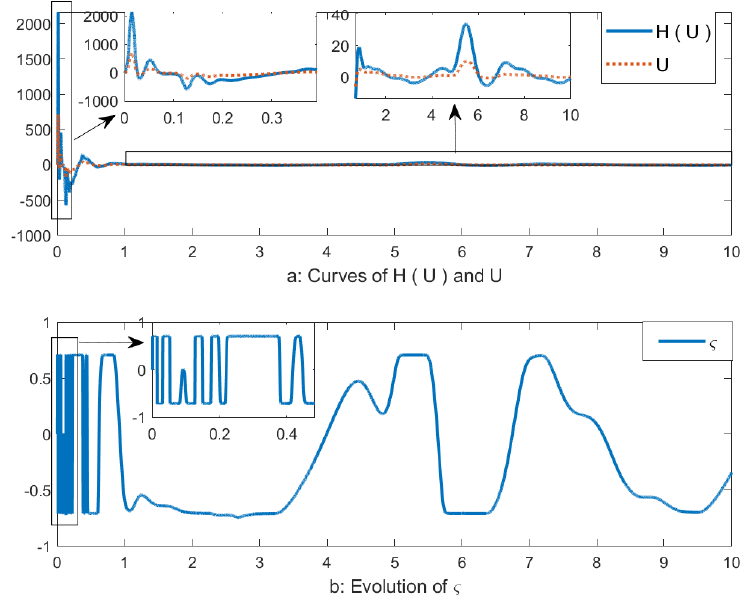
Figure 5. The control input and hysteresis nonlinearity.